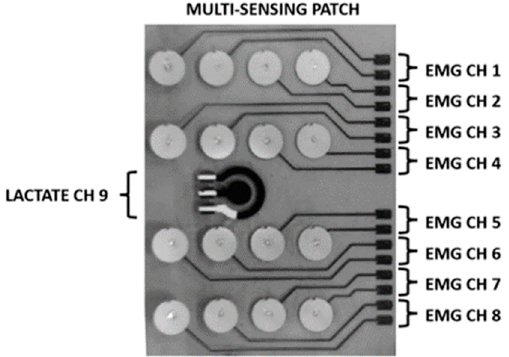
Figure 1. Multi-sensing system, described in our previous work [17], that simultaneously measures muscular fatigue by a sEMG array (EMG CH 1–8) and lactate concentration (LACTATE CH 9).